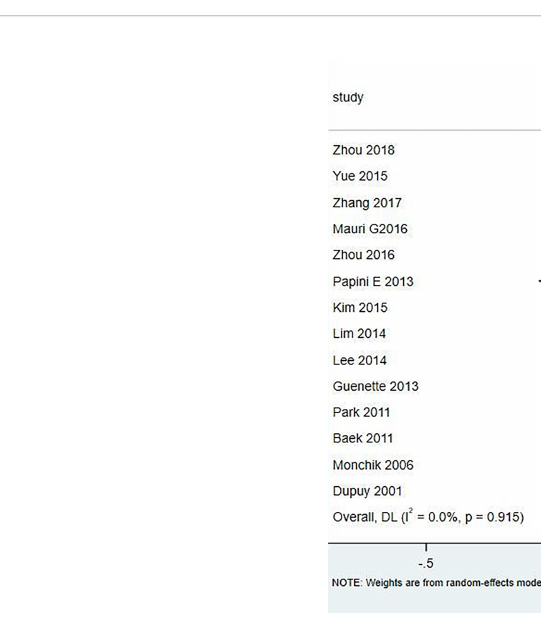
FIGURE 5 | Total complication rate of thermal ablation.